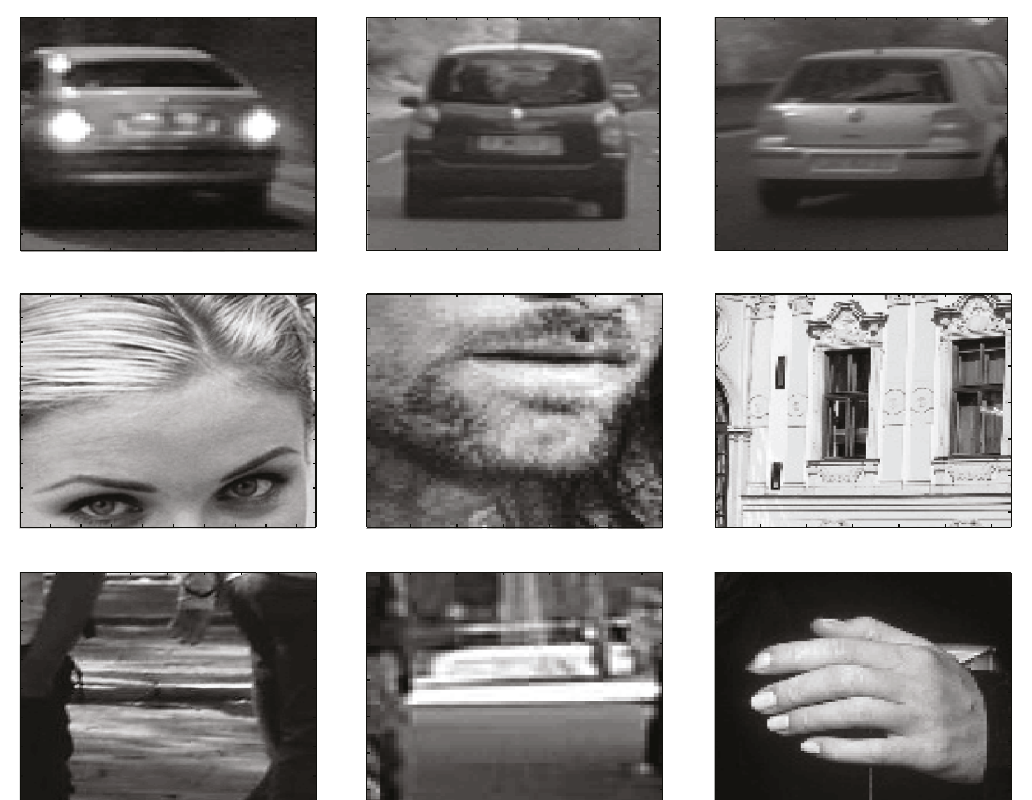
Figure 5: Positive and negative examples used for training. The first line shows positive examples (vehicle). The other lines show negative examples (nonvehicle) used to train the attentional cascade: easy examples used in first stages for the second line and di ffi cult examples used in the last stages for the third line.